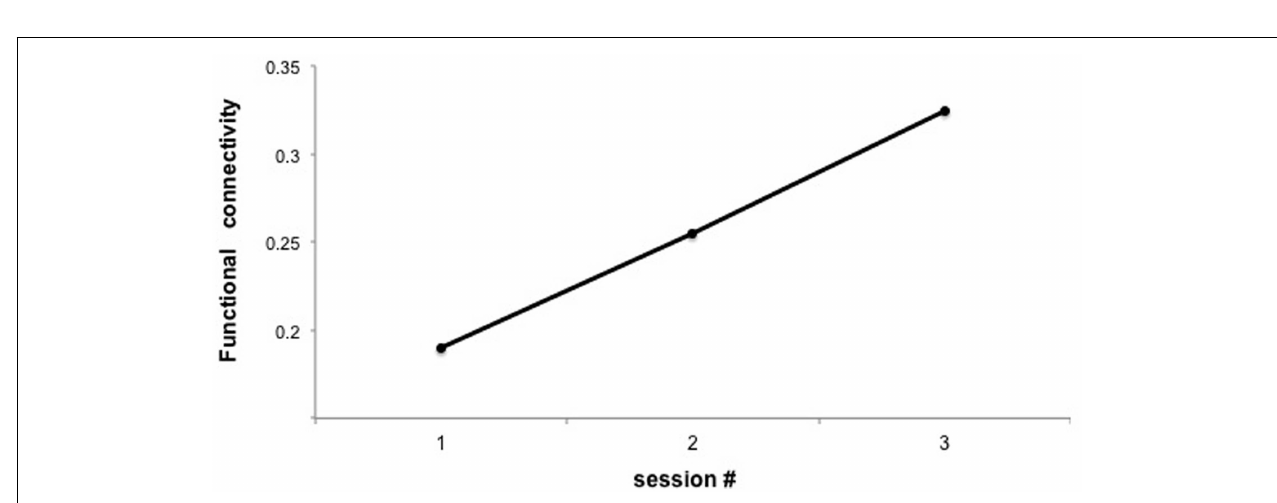
FIGURE 6 | “Outgoing and incoming connections of each ROI of the emotional network during up-regulation.” Outflow: number of outgoing connections from each of the ROIs. Inflow: number of incoming connections to each of the ROIs.The figure graphically represents the connections